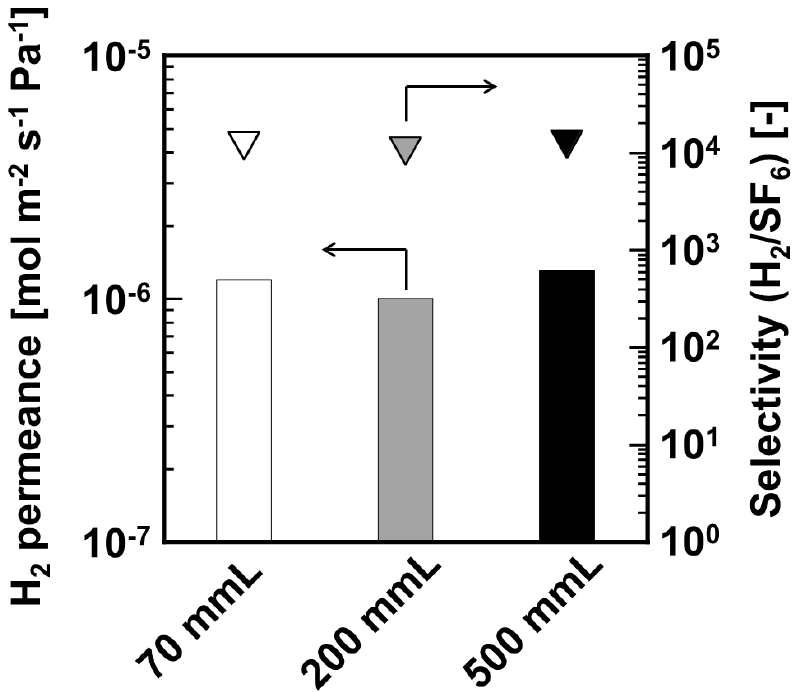
Figure 3. Hydrogen permeation performance of DMDPS-derived silica membrane having different effective membrane lengths at 573 K.